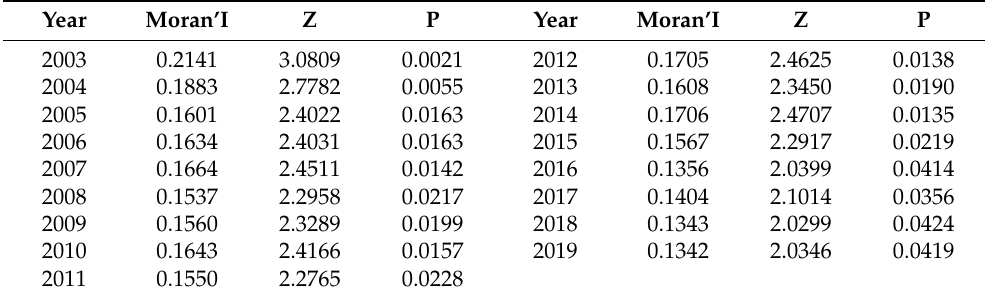
Table 2. Global Moran I index of agricultural water output intensity from 2003 to 2019.